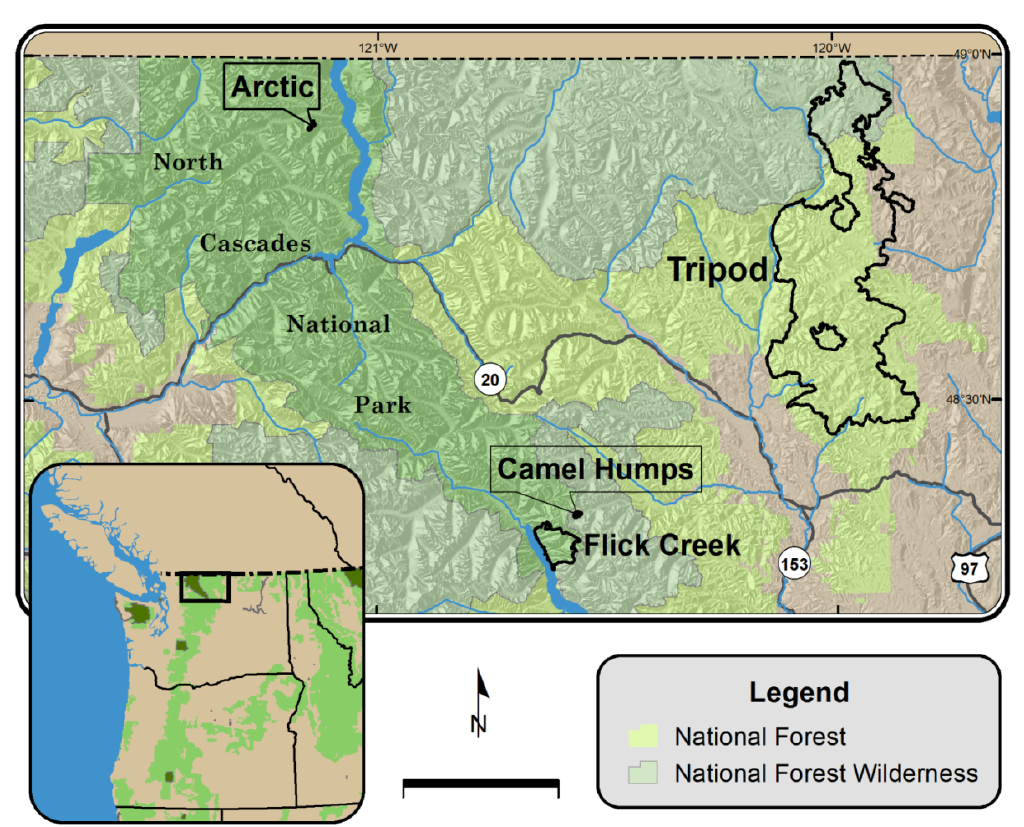
Figure 1. The four fires assessed in this study, labeled and outlined in black, are located in the northern Cascade Range of Washington, USA. The polygon within the Tripod fire is an area that burned approximately 30 years earlier, and was unburned by the